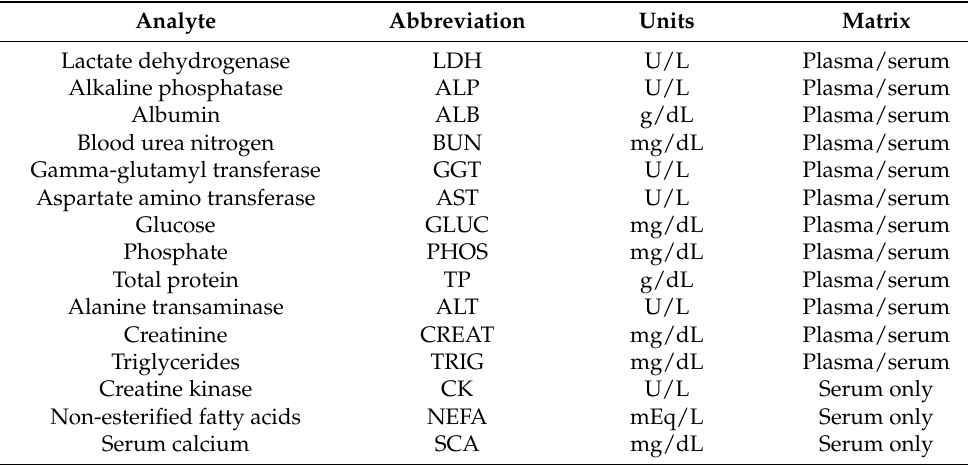
Table 3. Measured parameters for blood plasma and